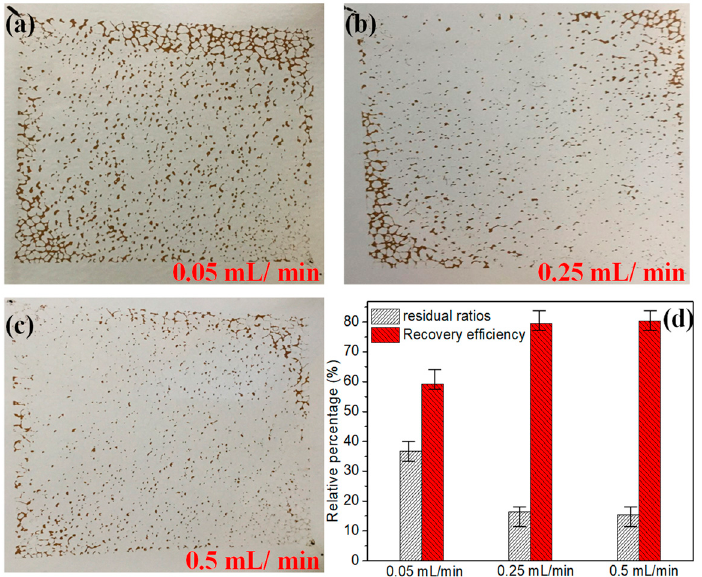
Figure 2. Distribution characteristics and recovery efficiency of residual oil under different water flooding rates. ( a ) 0.05, ( b ) 0.25, ( c ) 0.5, and ( d ) oil recovery efficiency.